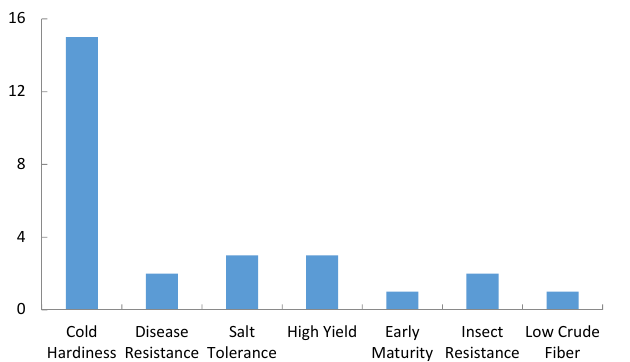
Figure 1. The number and reported general attributes of alfalfa varieties bred in Figure 1 . The number and reported general attributes of alfalfa varieties bred in China.